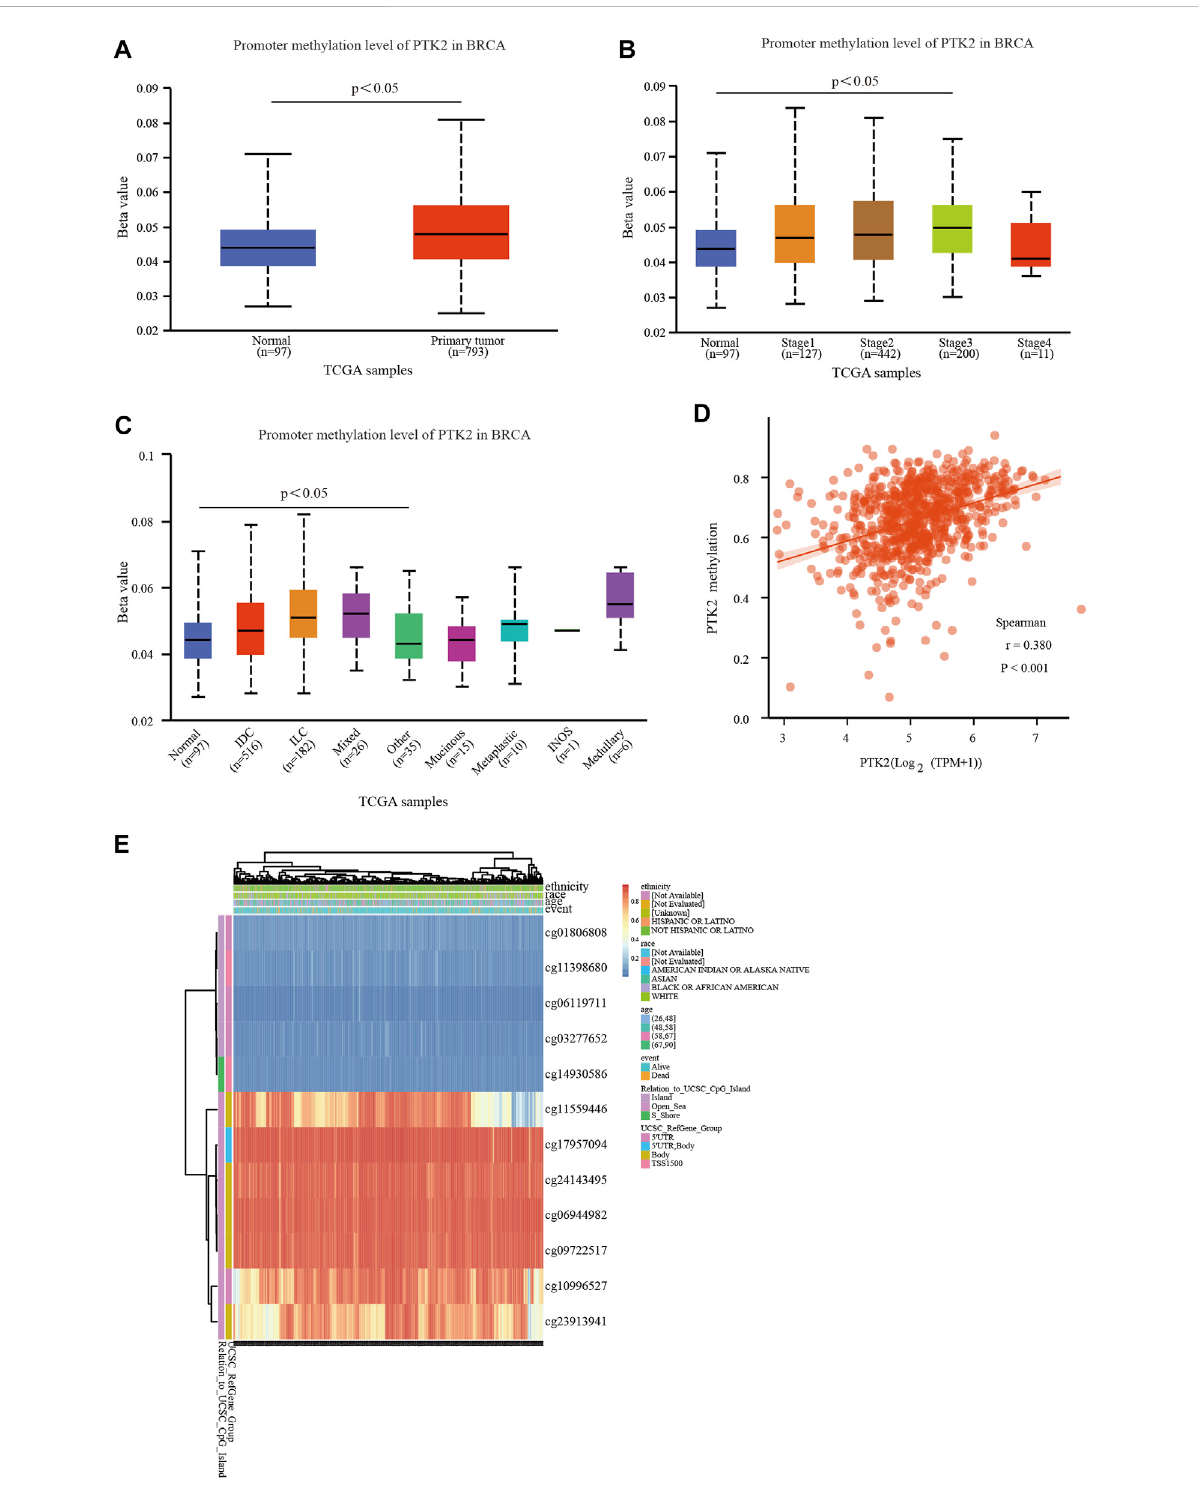
FIGURE 7 DNA methylation level and its prognostic value of PTK2 in breast cancer. (A) Promoter methylation of PTK2 in normal and cancer tissues from TCGA-breast cancer data. (B,C) Promoter methylation level of PTK2 in breast cancer of different tumor stages and tumor types using the UALCAN database. (D) Correlation between PTK2 methylation and its expression level. (E) Heat map of DNA methylation at CpG sites in the PTK2 gene using the MethSurv